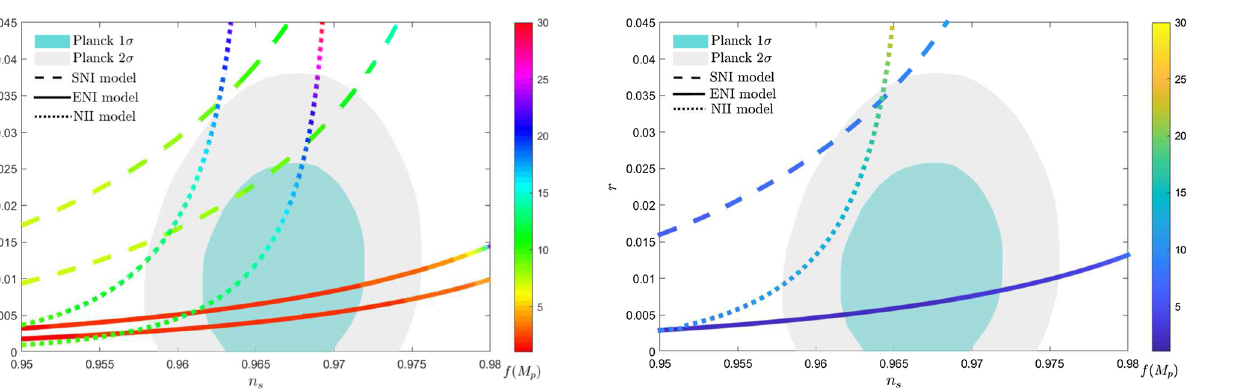
Fig. 1 Therelationshipbetween r and n s forthreesingle-fieldNImod- elsunderdifferent N k ∈ [ 55 , 65 ] .Thedashedline,solidanddottedlines represent the relationship between n s − r under the SNI model, ENI model, and NII model, respectively. Among the ENI model, we choose m = 0 . 1 for subsequent discussion. The colored gradient graph corre- sponds to the value of decay constant varying from 1 M p to 30 M p . In addition, the light blue and light grey broadband correspond to the latest combination 1 σ and 2 σ experiment errors of BAO, BICEP/KECK, and Planck data, respectively [49]